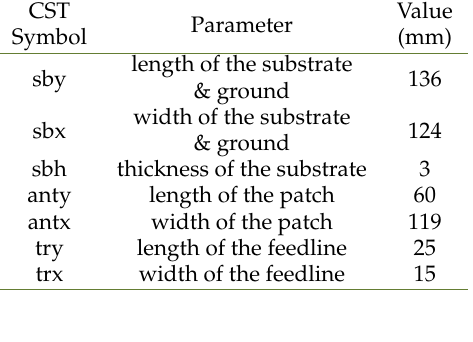
Table 1. Design parameters and